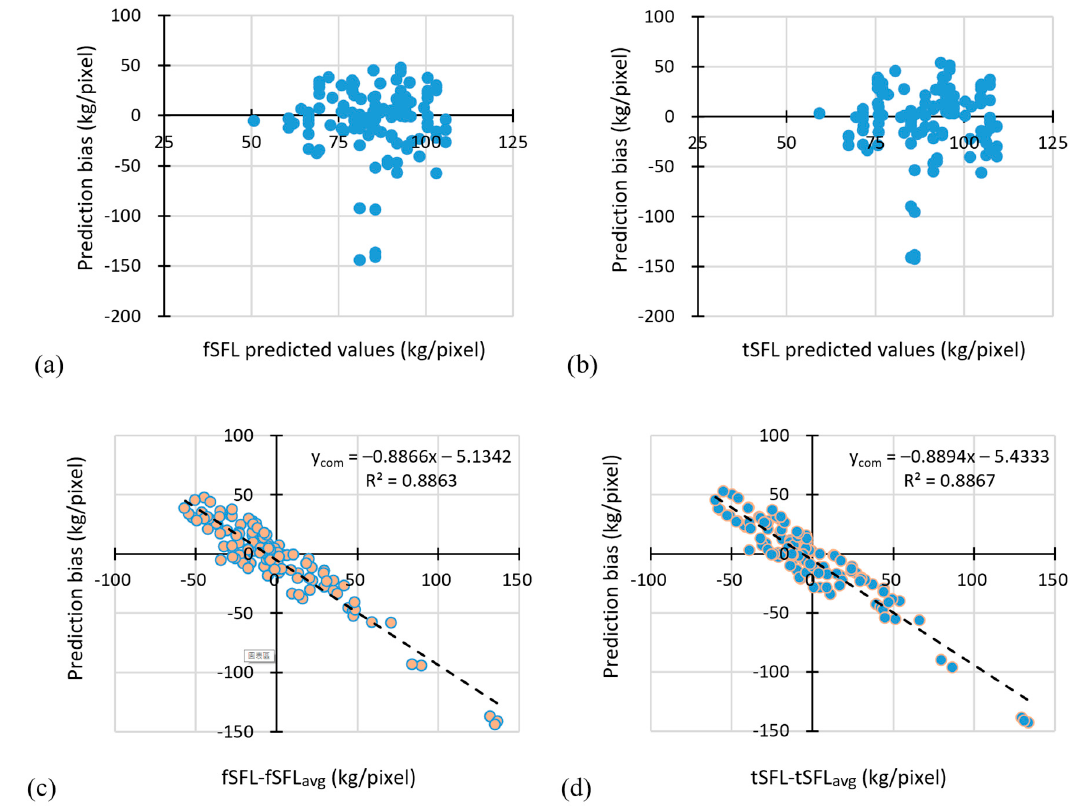
Figure 9. An examination of prediction bias of surface fuel loadings. The independency between the bias and predicted values of fSFL ( a ) and tSFL ( b ) via Equations (4) and (6). A linear dependency of the surface fuel mass estimation bias on the deviation from the mean of the observed values was formulated as a bias-adjustment model of Bias–adjfSFL–MLR for the estimate of fSFL shown in ( c ) and Bias–adjtSFL–MLR for the estimate of tSFL shown in ( d ). The compensated value (y com ) derived from the bias-adjustment model can be applied to appropriately restore surface fuel loading by subtracting y com from the originally estimated value of fSFL or tSFL.